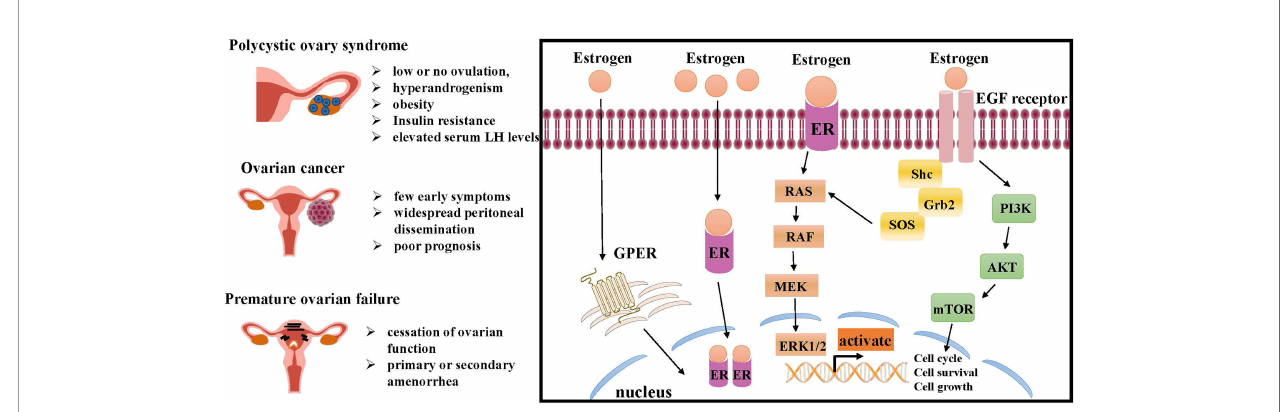
FIGURE 2 | Molecular pathways of ER regulation in ovarian lesions, like PCOS, ovarian cancer and premature ovarian failure (POF). The interaction of estrogen and ER can initiate intracellular signaling cascades leading to downstream activation of MAPK signaling and PI3K/AKT signaling, both of which are critical for cell growth and proliferation. Estrogen also promotes ovarian disease by regulating GPER. ER, estrogen receptor; RAS, renin-angiotensin system; RAF, residual adversarial fusion; MEK, mitogen-activated protein kina; ERK, extracellular regulated kinase; Grb, cytotoxic protease granzyme B; EGF, epidermal growth factor; PI3K, phosphoinositide 3-kinase; AKT, mTOR, mammalian target of rapamycin; GPER, G-protein-coupled estrogen receptor.